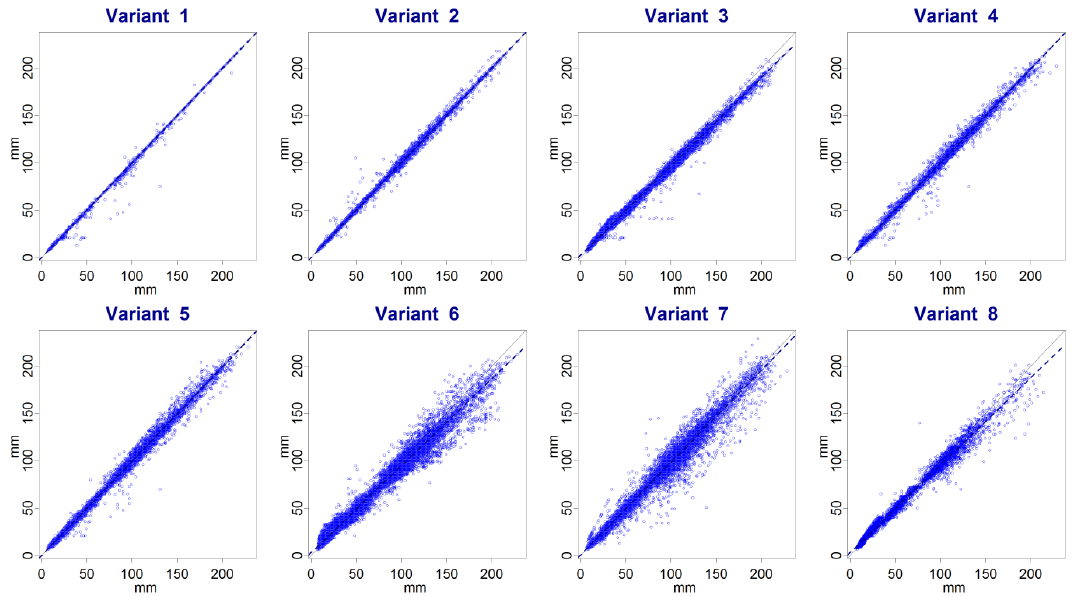
Figure 10. Monthly evapotranspiration of the wetland sub-areas of model variants 1 to 8 compared to the original model variant 0 (solid line—1:1 line, dashed blue line—regression line, efficiency parameter in Table 4). Table 4. Summary of the efficiency parameters for water balance values within the wetland. Variants 1 to 8 are compared with variant 0 (RMSE—root mean square error, σ res —standard deviation of the residuals, NSE—Nash-Sutcliffe Efficiency, r 2 —Pearson coefficient of determination, n = 25,460 for variants 1 to 7, n = 5628 for variant 8).